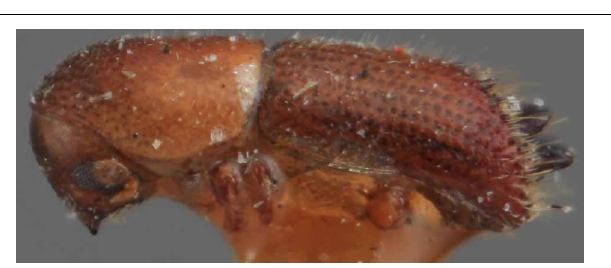
FIGURE 4 | Lateral view of the holotype of Premnophilus quadrispinosus , the type species of Premnophilus . Specimen length is approximately